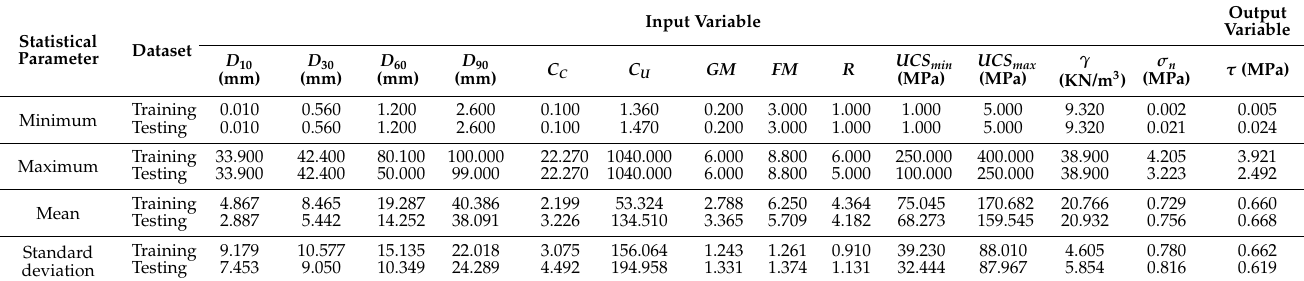
Table 2. Statistics of parameters of the training and testing